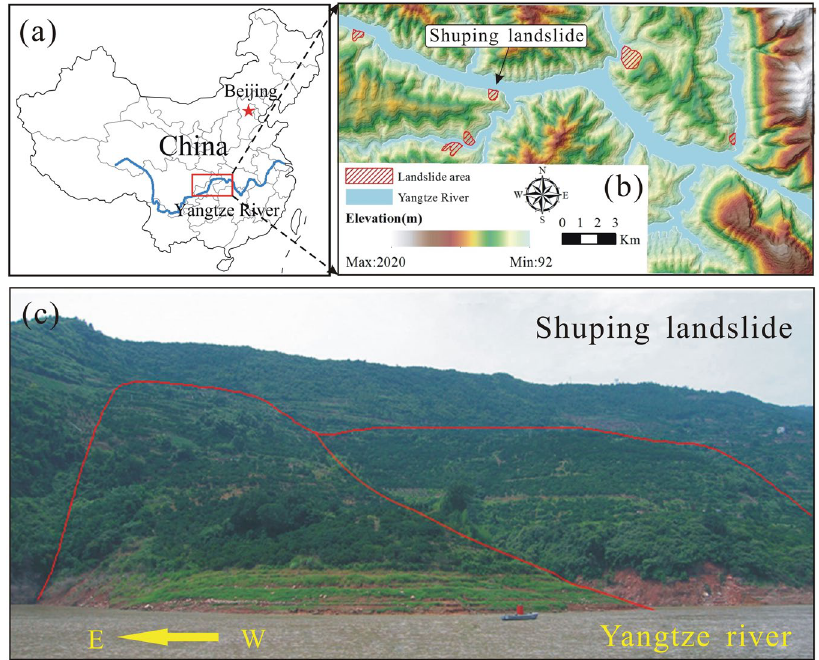
Figure 1. ( a ) Map of China; ( b ) Map showing the location of the Shuping landslide; and ( c ) Photograph of the Shuping landslide (The two maps was created by Chao Zhou using ArcGIS 9.3,